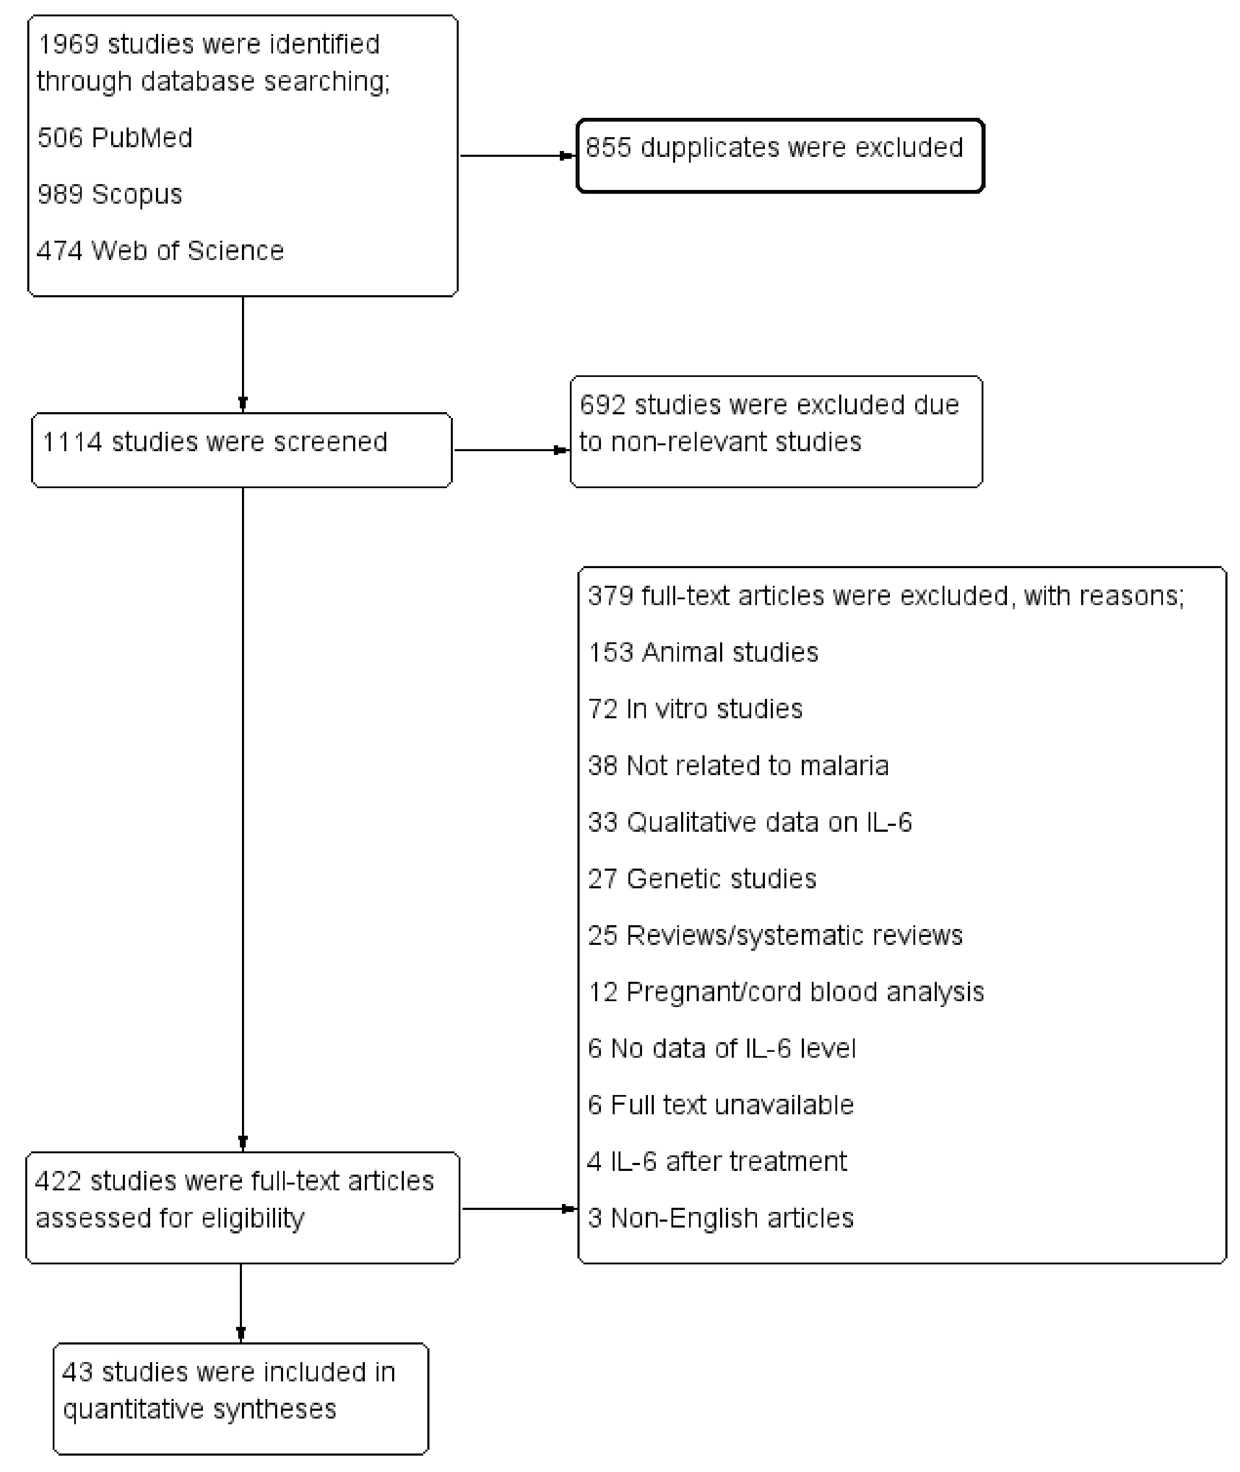
Figure 1. Study flow